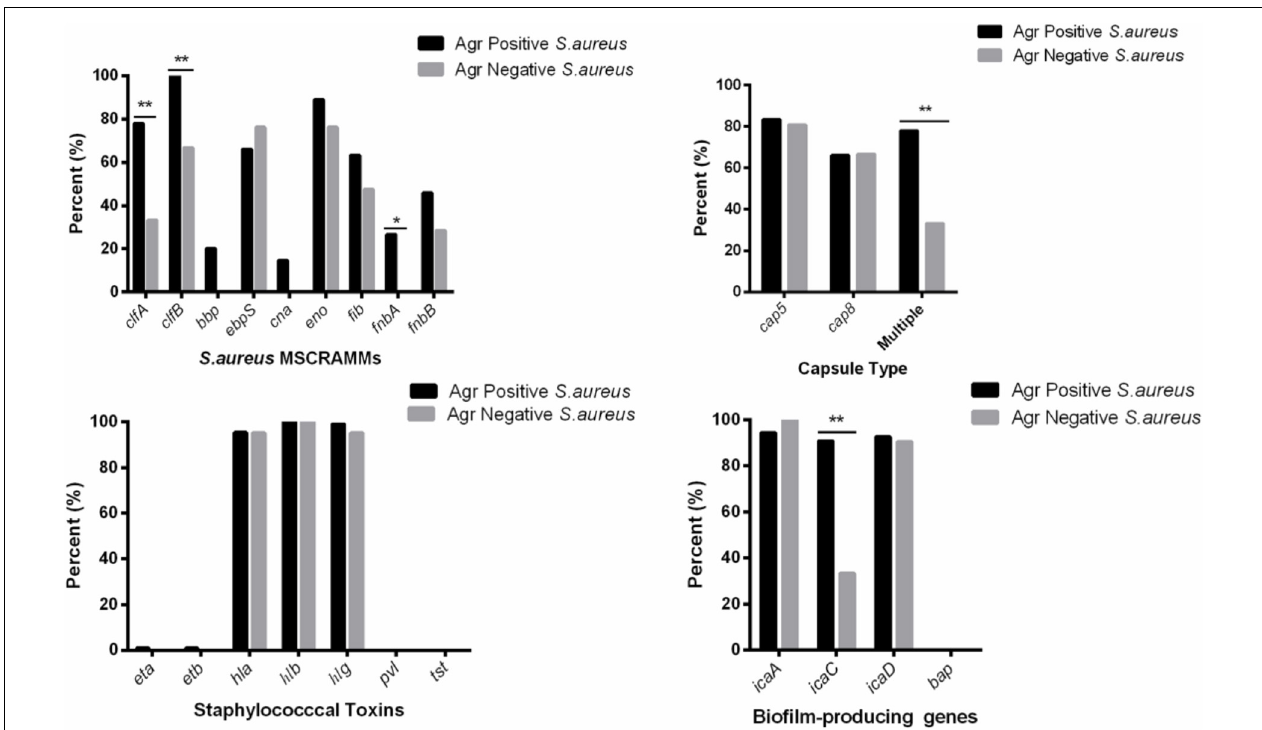
FIGURE 3 | Distribution of staphylococcal virulence associated genes between agr -positive and agr -negative S. aureus . Pearson’s chi-square test (two-tailed) was used to test the difference in the virulence determinants distribution between agr -positive isolates and agr -negative isolates. ∗ Demonstrates that the distribution of toxin genes was statistically significantly different in isolates from different agr types ( p < 0.05); ∗∗ Demonstrates that the distribution of toxin genes was more significantly different in isolates from different agr types ( p < 0.01).